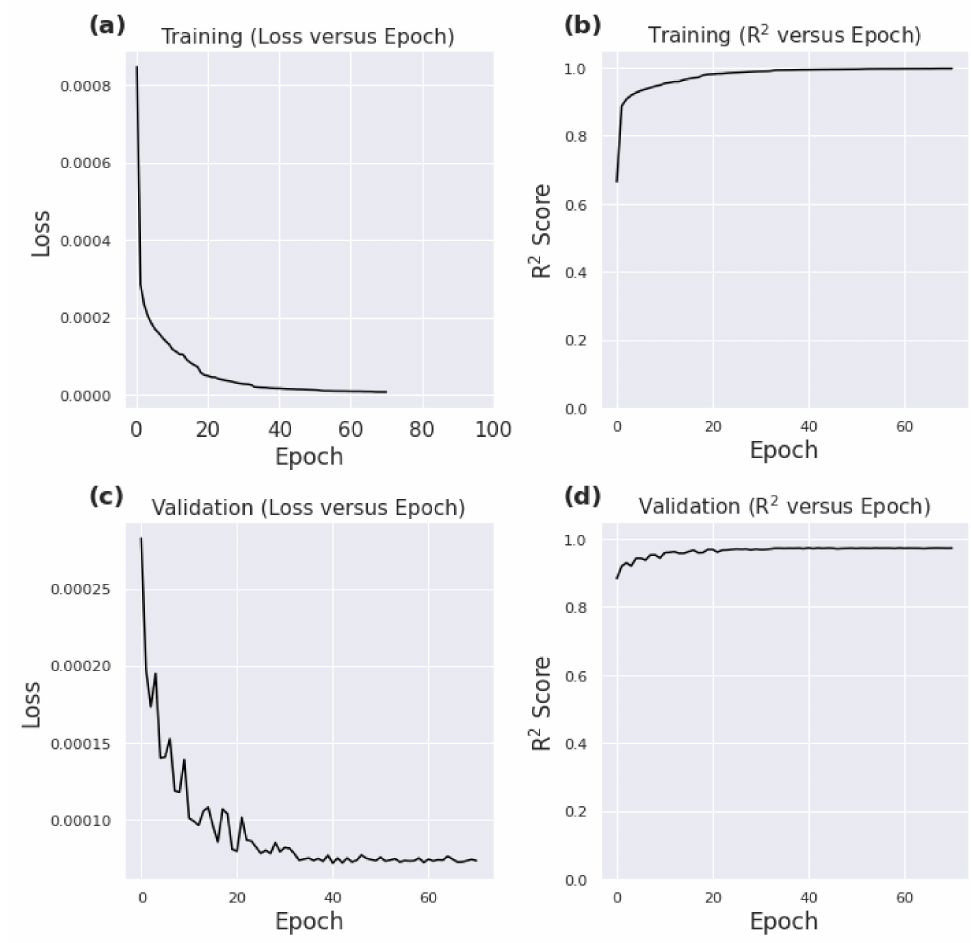
Figure 4. ( a ) Loss versus epochs plot for training, ( b ) R 2 versus epochs plot for training, ( c ) loss versus epochs for validation, and ( d ) R 2 versus epochs for